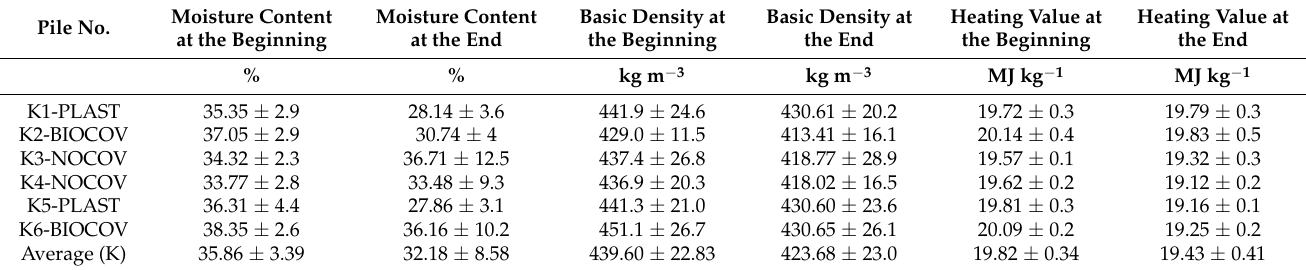
Table 2. Developments of moisture content, ash content, basic density, and heating values of the studied piles in the Kuopio (K) experiment in average values and standard deviations.